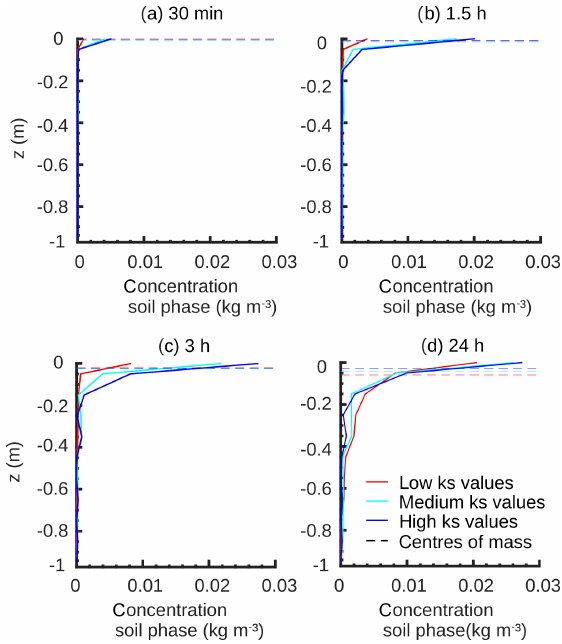
Figure A1. Time series of bromide tracer concentration profiles and centres of mass at different k s values during the rainfall event (a, b) , shortly after it (c) and at the end of simulation (d) .